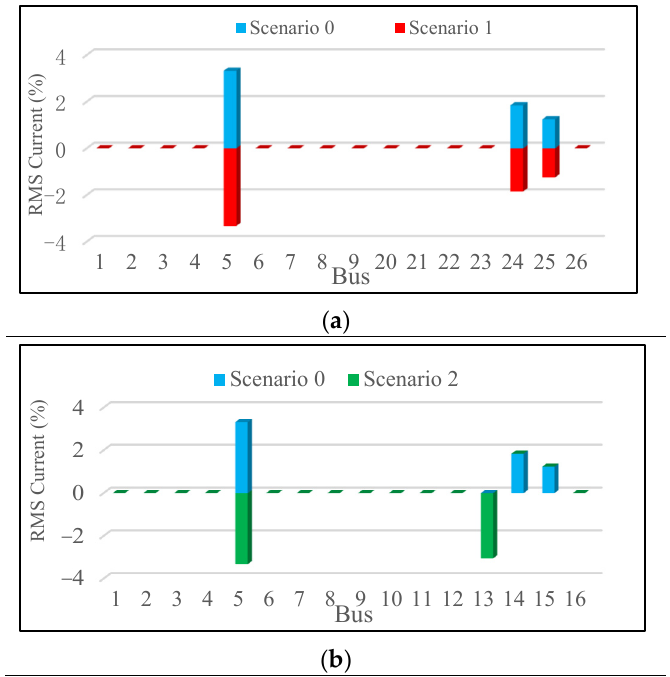
Figure 16. The RMS value of nonlinear loads compared to RMS value of SACAPF injection currents. ( a ) Scenario 1 and ( b ) Scenario 2.